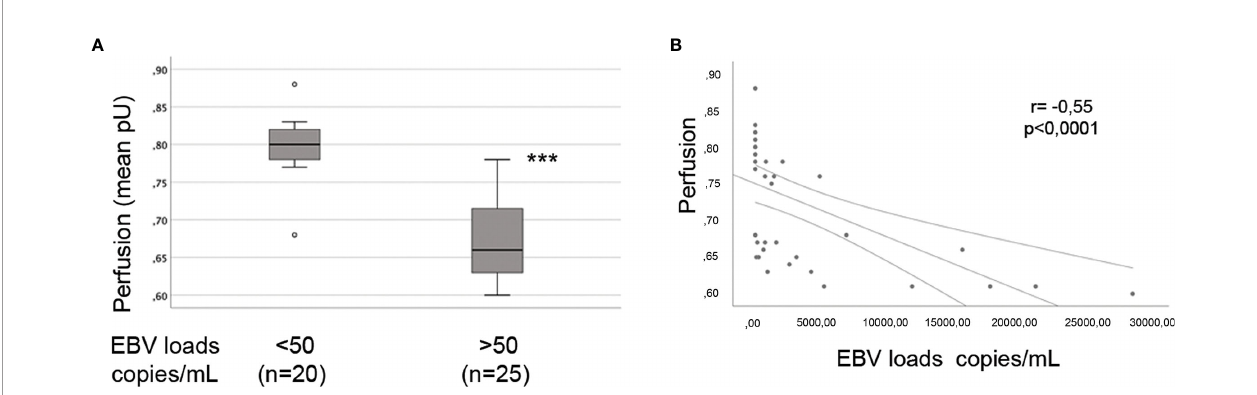
FIGURE 9 | Increased EBV loads inversely correlate with hand perfusion in SSc patients. EBV DNA was extracted from whole blood and quanti fi ed by qPCR. EBV quantitative curve was generated using ABI`s Viral load control. qPCR analysis was performed using primers and probe designated to ampli fi ed the EBV polymerase BALF5, and measured using SYBR Green chemistry. Shown here are copies of viral DNA calculated by standard curve. (A) SSc patients with signi fi cantly higher level of EBV DNA loads show reduction in the hand perfusion compared to SSc patients with low or undetectable level of EBV DNA loads. Mann-Whitney test was used for statistical analysis (B) Inverse correlation between increase of EBV DNA copies and reduction in blood perfusion in SSc patients (Spearman r=0.55, p<0.0001).